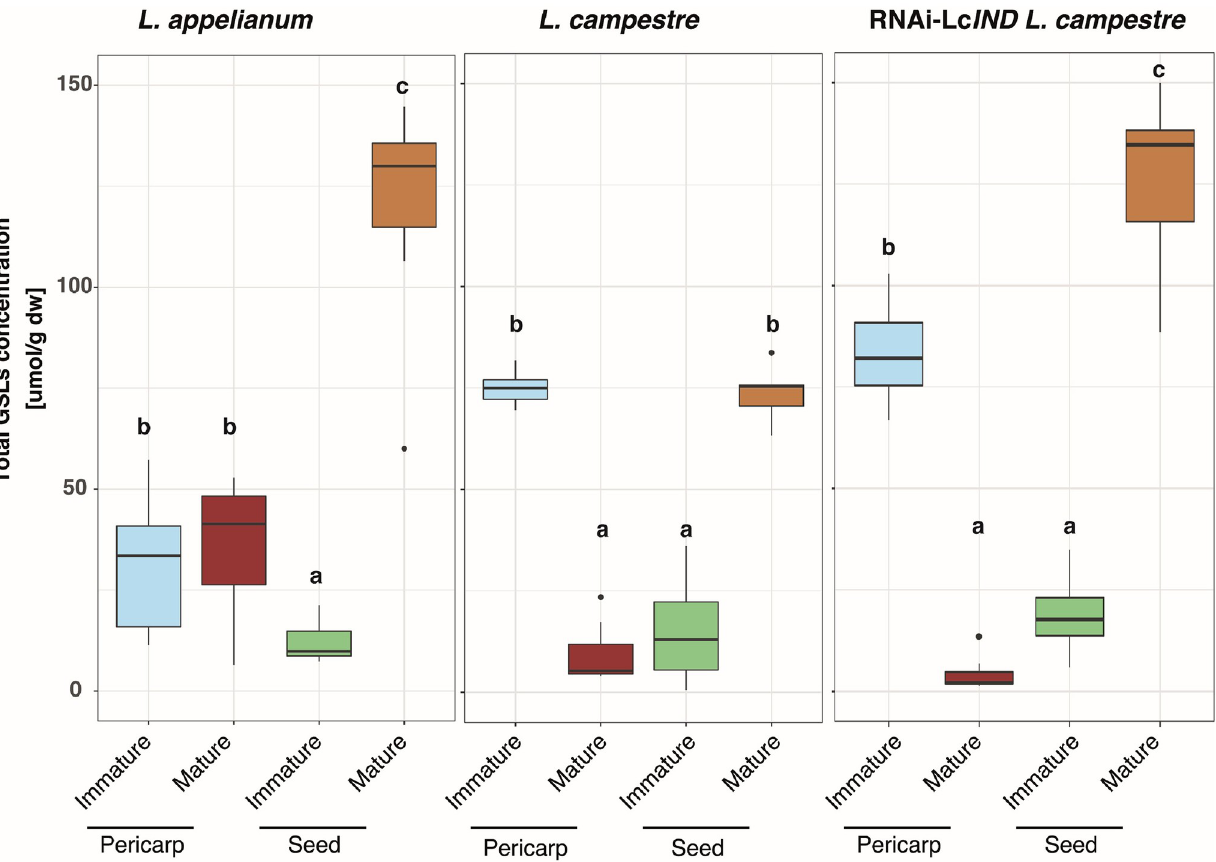
Fig 2. Total glucosinolate concentrations differ among tissue types (pericarp vs seed) of immature and mature diaspores of Lepidium appelianum , L . campestre , and transgenic RNAi- LcIND L . campestre . The concentrations of the total glucosinolates ( μ mol g -1 DW) are displayed as box-whisker plots. Boxes show the median (line) as well as the 25 th and 75 th percentiles, whiskers extend to the 5 th to 95 th percentiles and dots indicate outliers, n = 7. Different letters within each plot indicate a significant difference in mean values in Tukey’s post-hoc analysis following two factorial general linear models analyses of variance (see Table 1) on the effects of ontogeny (mature and immature) and tissue type (pericarp and seed) on total glucosinolate concentrations.